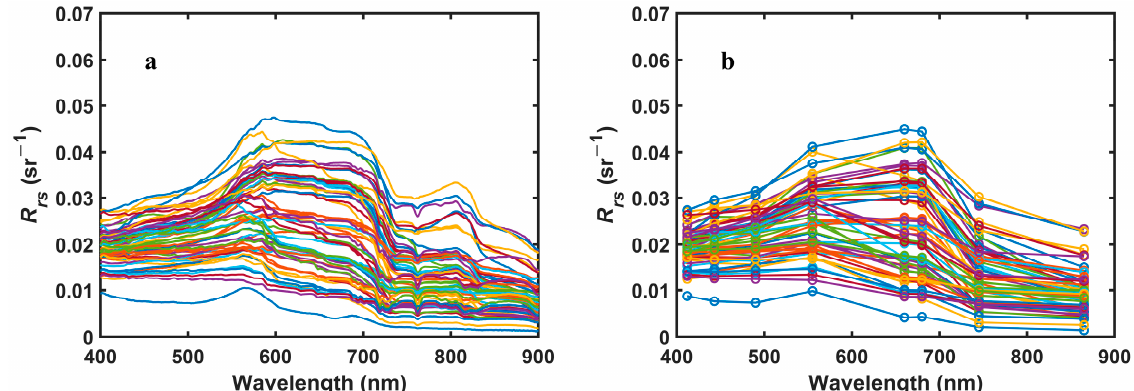
Figure 2. ( a ) The measured remote sensing reflectance ( R rs ) spectrum of the Zhoushan Archipelago. ( b ) The spectrum of the measured R rs corresponding to the Geostationary Ocean Color Imager (GOCI) bands.